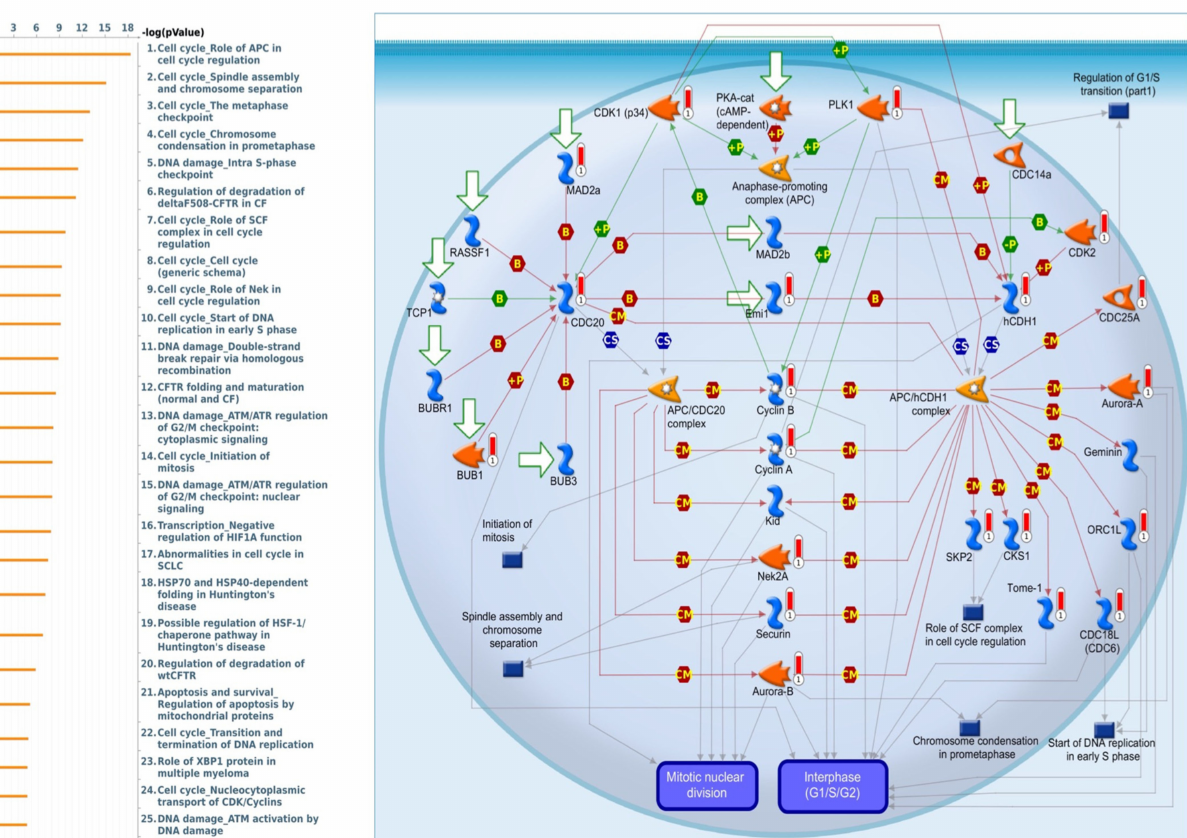
Figure 12. List of co-expressed genes with Solute carrier 35A2 (SLC35A2) co-expressed in BRCA database was analyzed using a MetaCore enrichment pathway analysis. The strategy was to compile lists of the top 10% expressed genes from both the METABRIC (2000 genes) and Pan-Cancer (1800 genes) prior to overlapping them to create a total gene list of 1201. The gene list was taken from TCGA Pan-Cancer Atlas and METABRIC BRCA patient databases while the pathway list was organized by the − log[ p -value]. When doing the biological process analysis, the route “Cell cycle_Involvement of APC in cell cycle regulation” was at the top of the